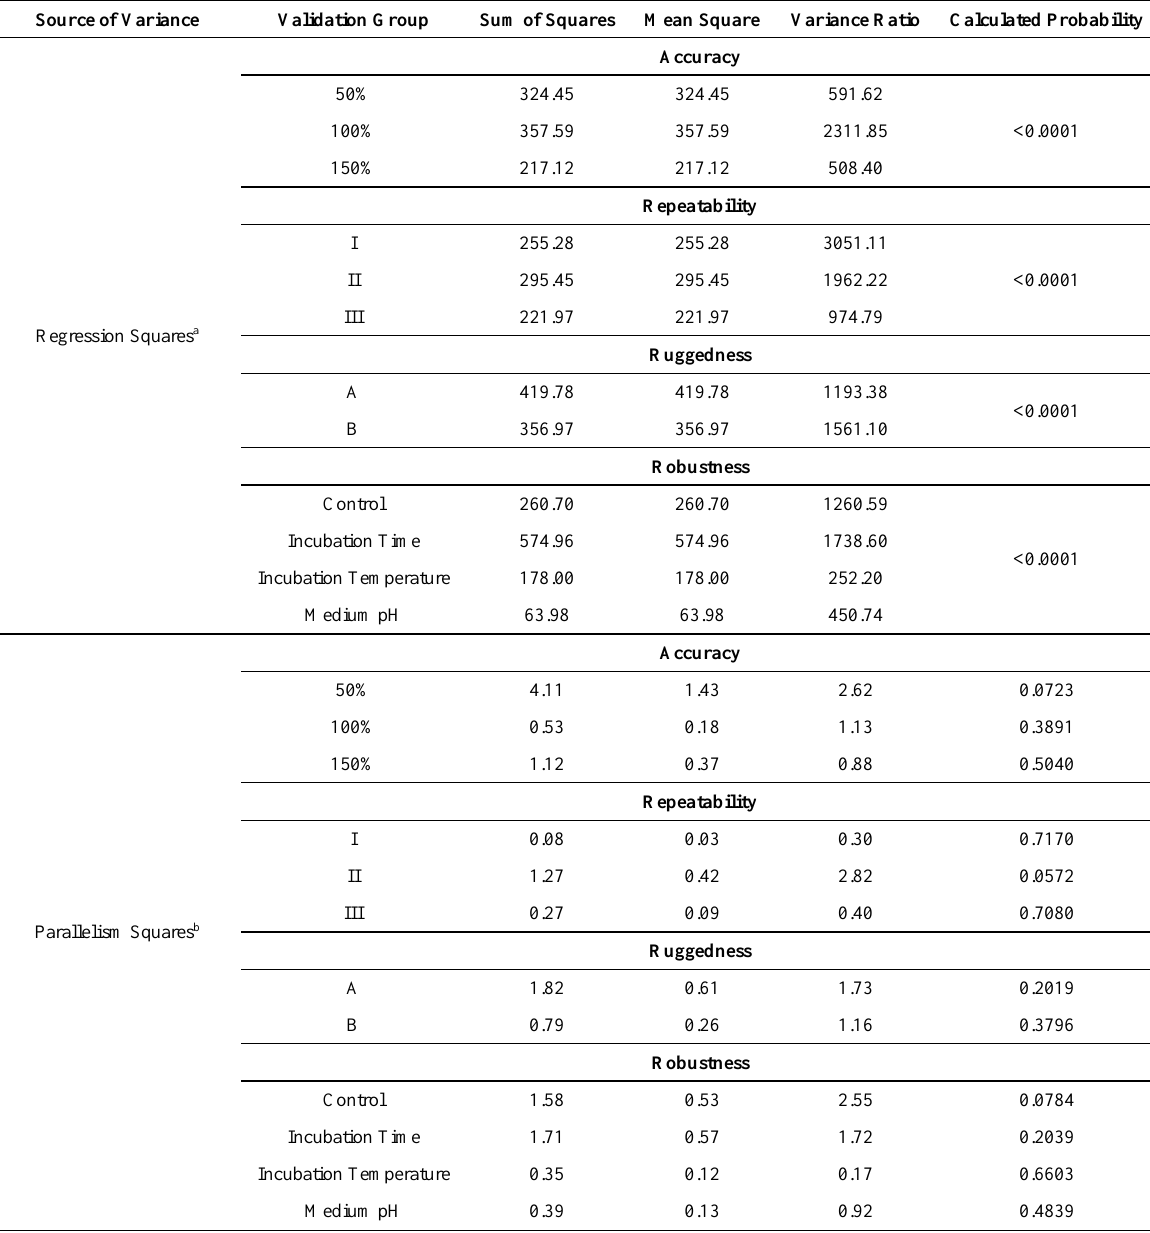
Table 6. Analysis of variance (ANOVA) of validation group for assessment of the assay design validity Source of